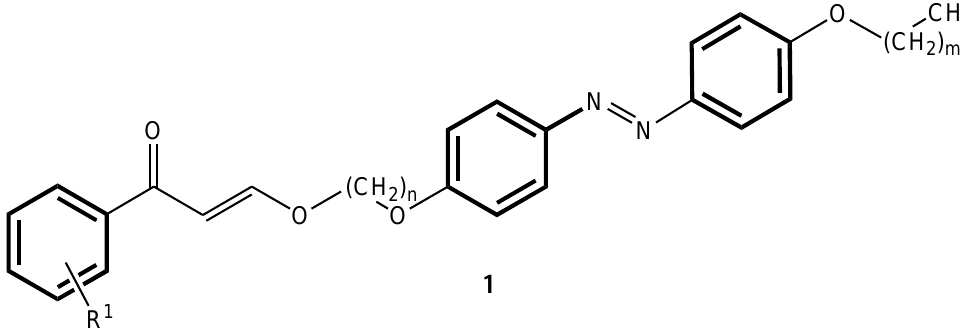
Figure 1. 4′ -alkoxy-4- (ω -cinnamoylalkoxy)azobenzene ( 1 ). Figure 1. 4 (cid:48) -alkoxy-4-( ω -cinnamoylalkoxy)azobenzene ( 1